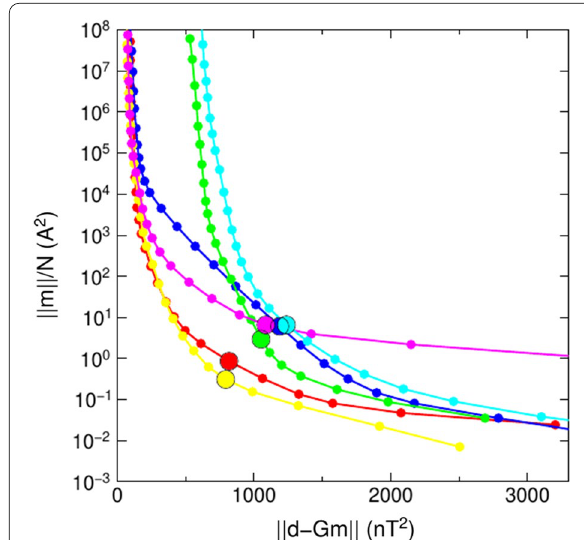
Fig. 9 Trade-off curves between data misfit and model resolution (the L-curves) for six selected Swarm A tracks (see Table 1). Red, blue, green, yellow, violet and light blue stand for tracks A4301, A4855, A4975, A5097, A8506 and A9012, respectively. The dotes denote chosen values of the regularisation parameter α 2 in the range between 1 × 10 − 19 nT 2 A − 2 and 1 × 10 − 8 nT 2 A − 2 . The corner values of the L-curves occur for α 2 between 1 × 10 − 11 nT 2 A − 2 and 3 × 10 − 11 nT 2 A − 2 . The common value of α 2 used for the analysis of the along-track data in Fig. 10 was chosen equal to α 2 = 2 × 10 − 11 nT 2 A − 2 (large circles). The norm of vector m is normalised by the number of model parameters N for better comparison between different